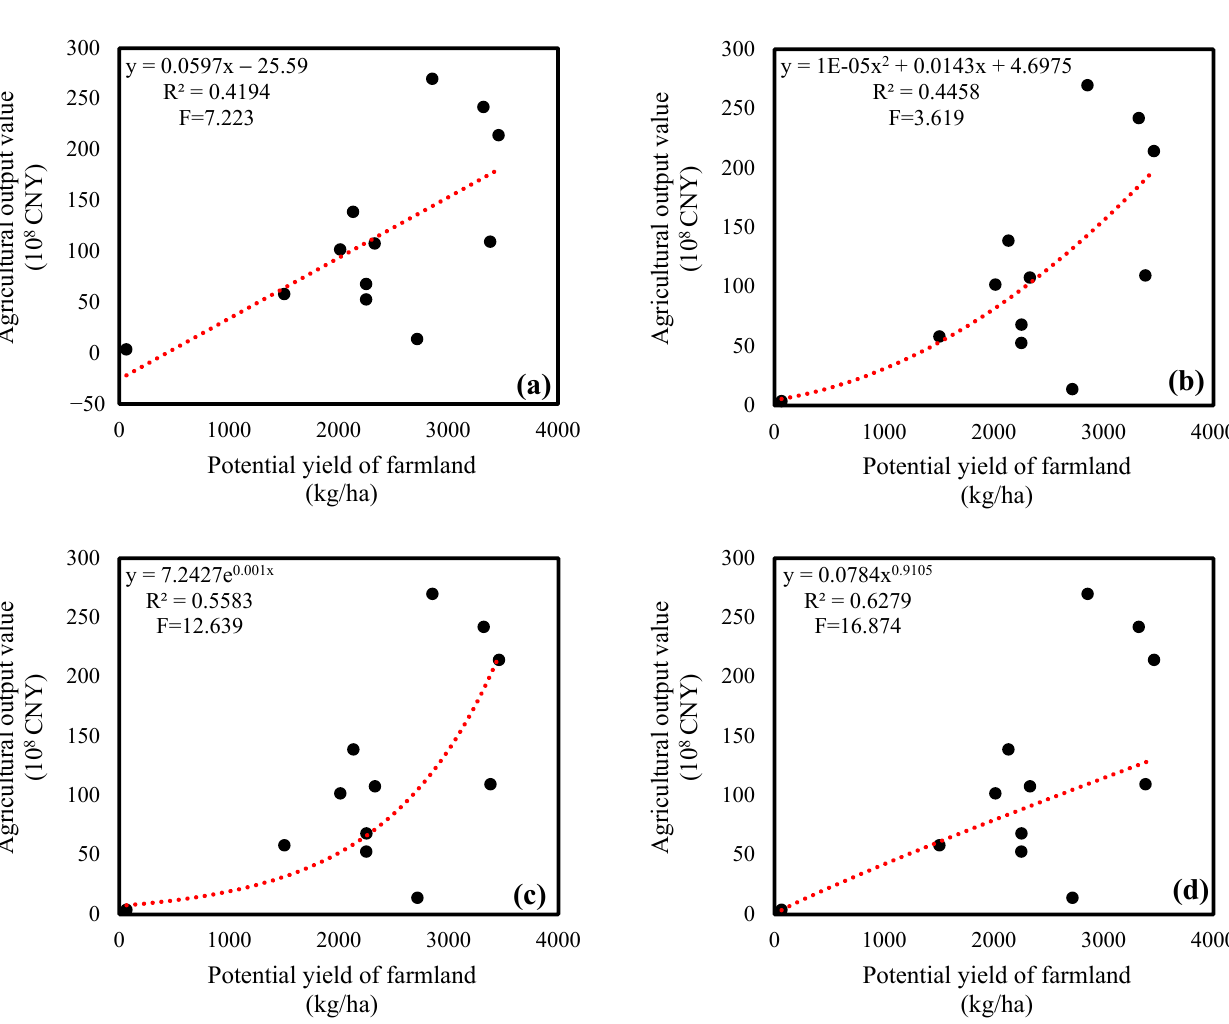
Figure A2. Statistical relationship between potential yield of farmland and agricultural output value: ( a ) Linear algorithm; ( b ) quadratic polynomial algorithm; ( c ) exponential algorithm; ( d ) power function algorithm.